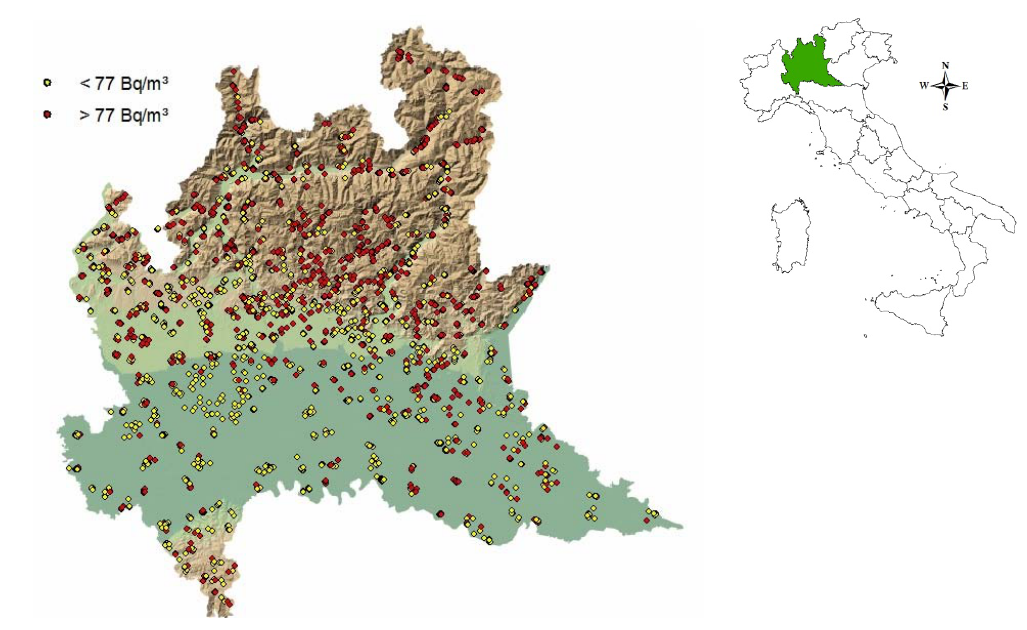
Figure 2. The study region: measurement point locations (indoor radon regional survey 2003–2004) classified according to whether the measured value is above or below the sample median.